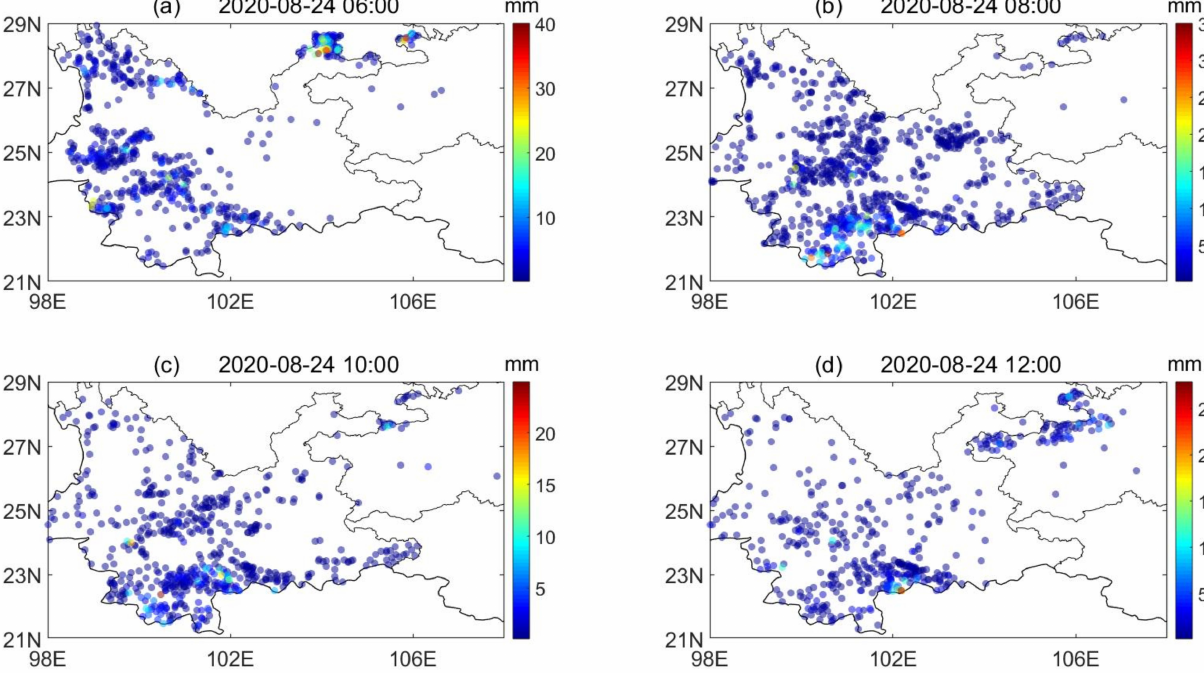
Figure 9. Precipitation at stations in Yunnan–Guizhou Plateau from 06:00 (UTC) to 12:00 on 24 August 2020 (scattered points represent stations with precipitation greater than, and color scales represent the amount of precipitation. ( a – d ) represent the results of 2 h